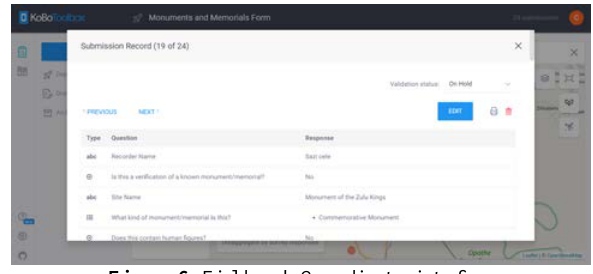
Figure 6: Fieldwork Coordinator interface